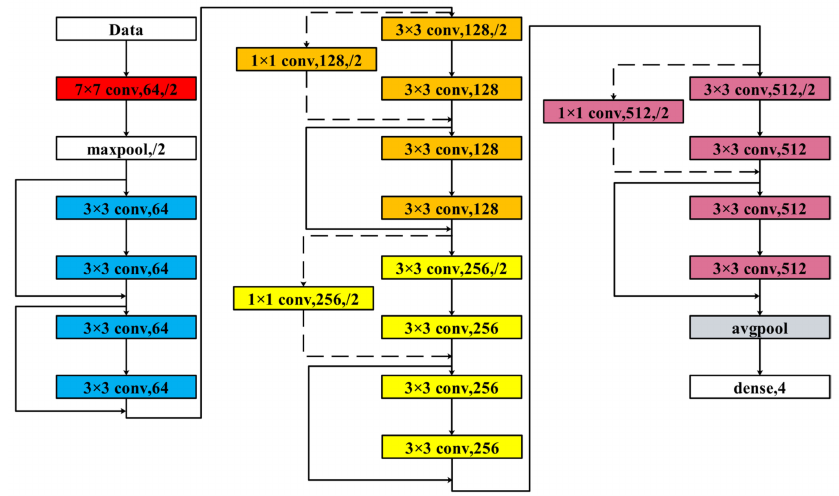
Figure 9. ResNet model structure.